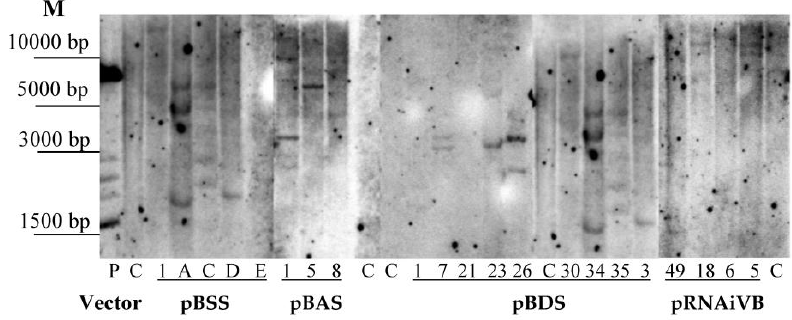
Figure 2. Southern blot analysis of transgenic chrysanthemum lines. Numbers and letters denote different transgenic lines. P—plasmid DNA of pBSS, C—nontransformed control plant, and M—molecular size marker.